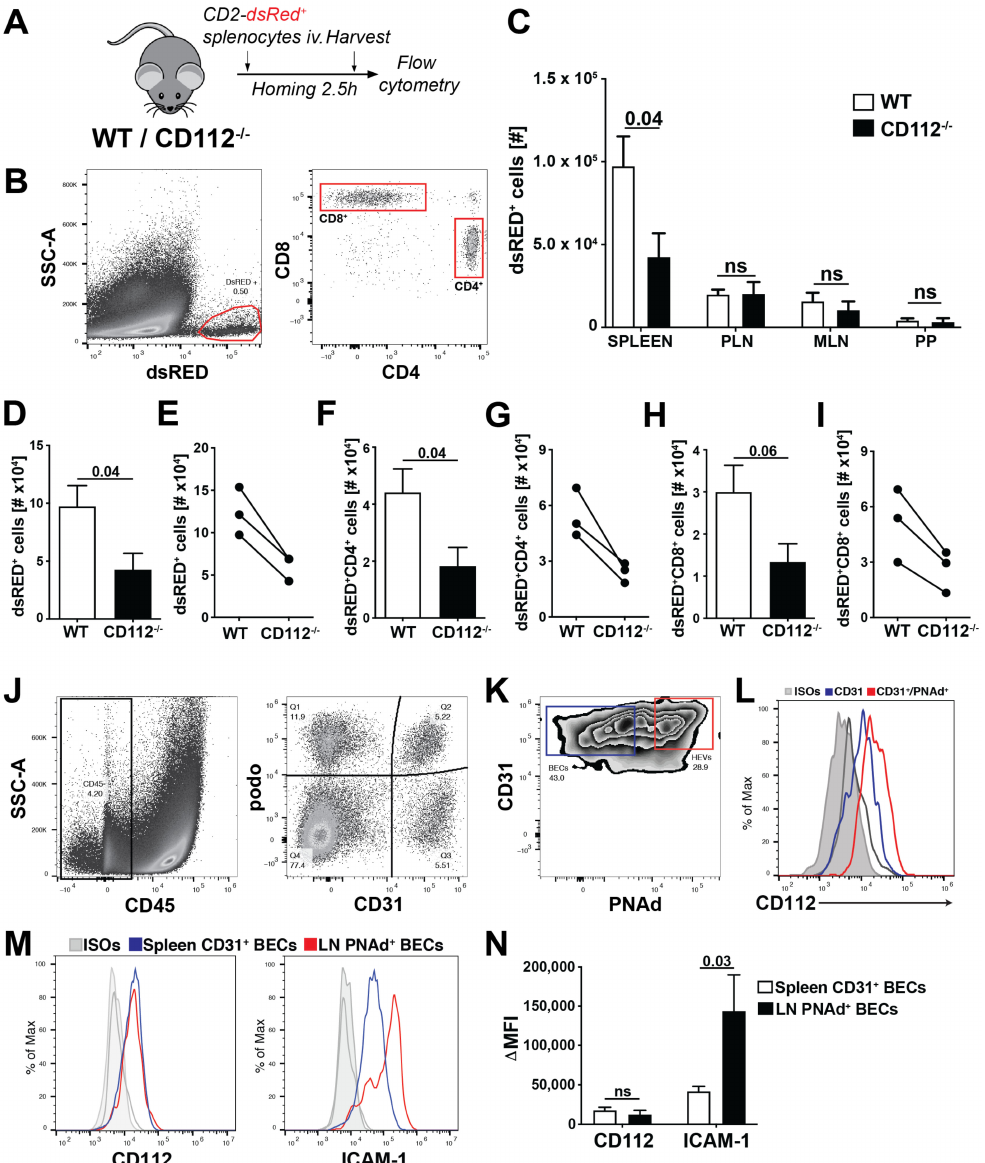
Figure 6. Absence of CD112 reduces homing of adoptively transferred T cells to spleen. ( A – I ) T cell homing experiment into secondary lymphoid organs (SLOs). ( A ) CD2-dsRED + leukocytes were injected intravenously into either WT or CD112-deficient mice. After 2.5 h, SLOs were harvested and the number of homed T cells was quantified with flow cytometry. ( B ) Representative gating strategy of adoptively transferred CD2-dsRED + T cells in murine spleen. Single-cell suspensions were gated on CD45 + CD2-dsRED + and further subdivided into CD4 + /CD8 + cells. ( C ) Numbers of adoptively transferred CD2-dsRED + T cells in different SLOs (PPs: Payer’s patches, MLN: mesentery LN, PLN: peripheral LN). Representative data from one out of three experiments are shown. n = 5–7 mice/group, ns = not-significant. ( D – F ) Quan- tification of ( D , E ) total CD2-dsRED + , ( F , G ) CD2-dsRED + CD4 + and ( H , I ) CD2-dsRED + CD8 + T cells in the spleen of WT and CD112 − / − mice from. ( D , F , H ) show representative data from one out of three independent experiments ( n = 5–7 mice/group/experiment) performed. ( E , G , I ) show a summary of the mean values obtained in the three individual ex- periments. Data points (WT—CD112 − / − ) from the same experiment are connected by a line. ( J – L ) Analysis of CD112 expression in LN HEVs. ( G ) Gating strategy of LN single-cell suspensions. CD45 − stromal cells were further divided by CD31 and podo expression. ( K ) HEV BECs were identified as podo − CD31 + PNAd + cells. Representative plots from three independent experiments are shown. ( L ) Representative histogram showing CD112 expression in CD31 + LN BECs (blue) and CD31 + PNAd + HEV BECs (red). ( M , N ) Comparison of CD112 and ICAM-1 expression in CD31 + PNAd + LN BECs and splenic CD31 + BECs. ( M ) Representative histograms and ( N ) quantification of the median fluorescent intensities (MFIs) from three independent